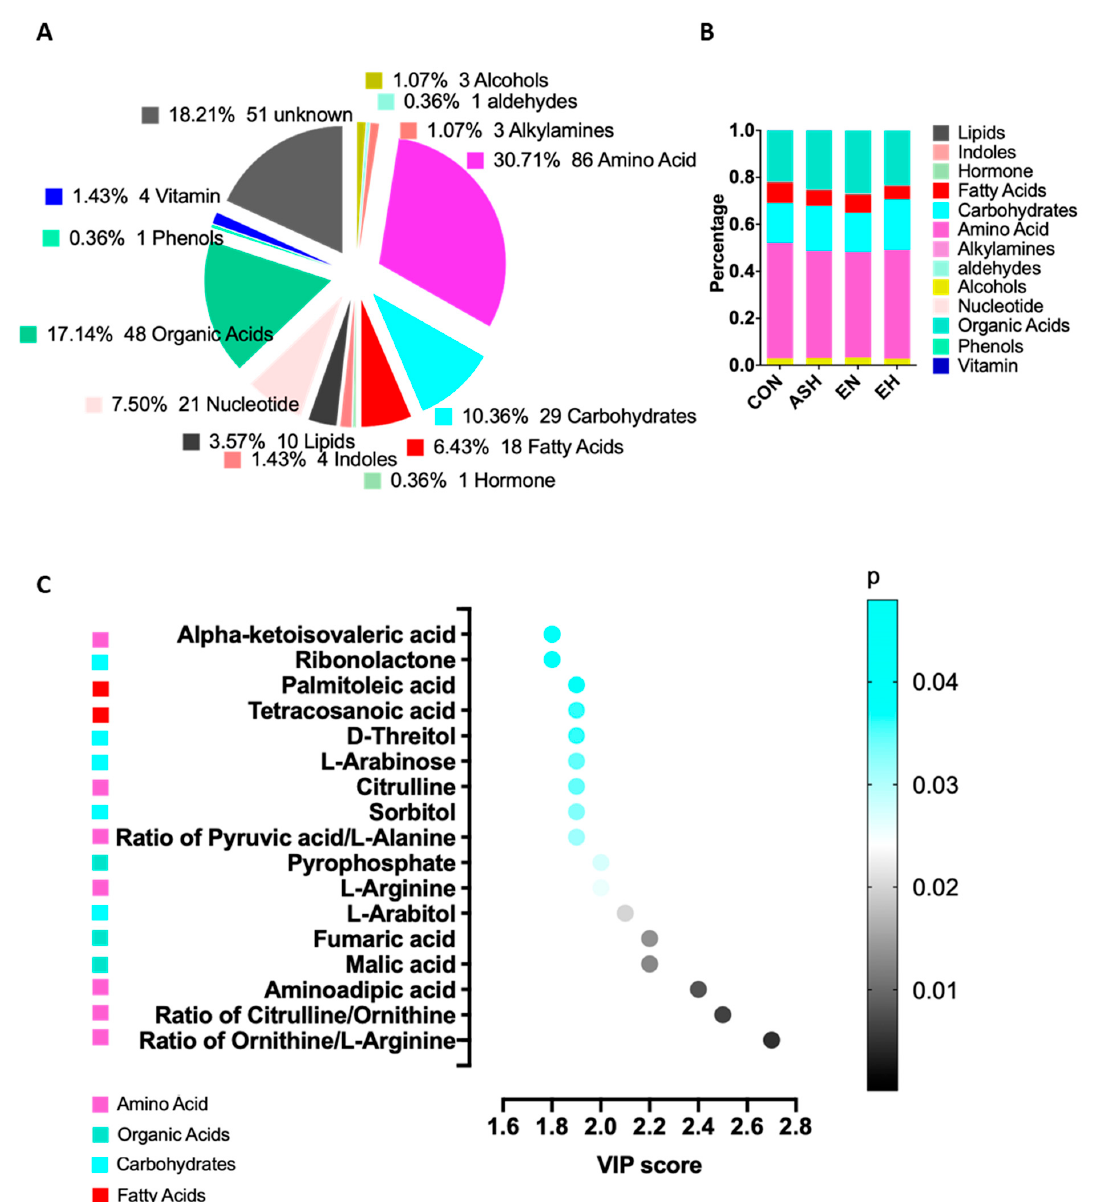
Figure 2. Circulating metabolomics profile and composition in asthma and control cohorts. ( A ) The serum metabolite kinds detected by the untargeted metabolomics profiling. ( B ) The compositions of each metabolite kinds indicated by respective percentage. ( C ) Variable importance in projection (VIP) and correlation coefficients assessment of significant metabolites and ratio between control and asthma calculated using an OPLS-DA model.